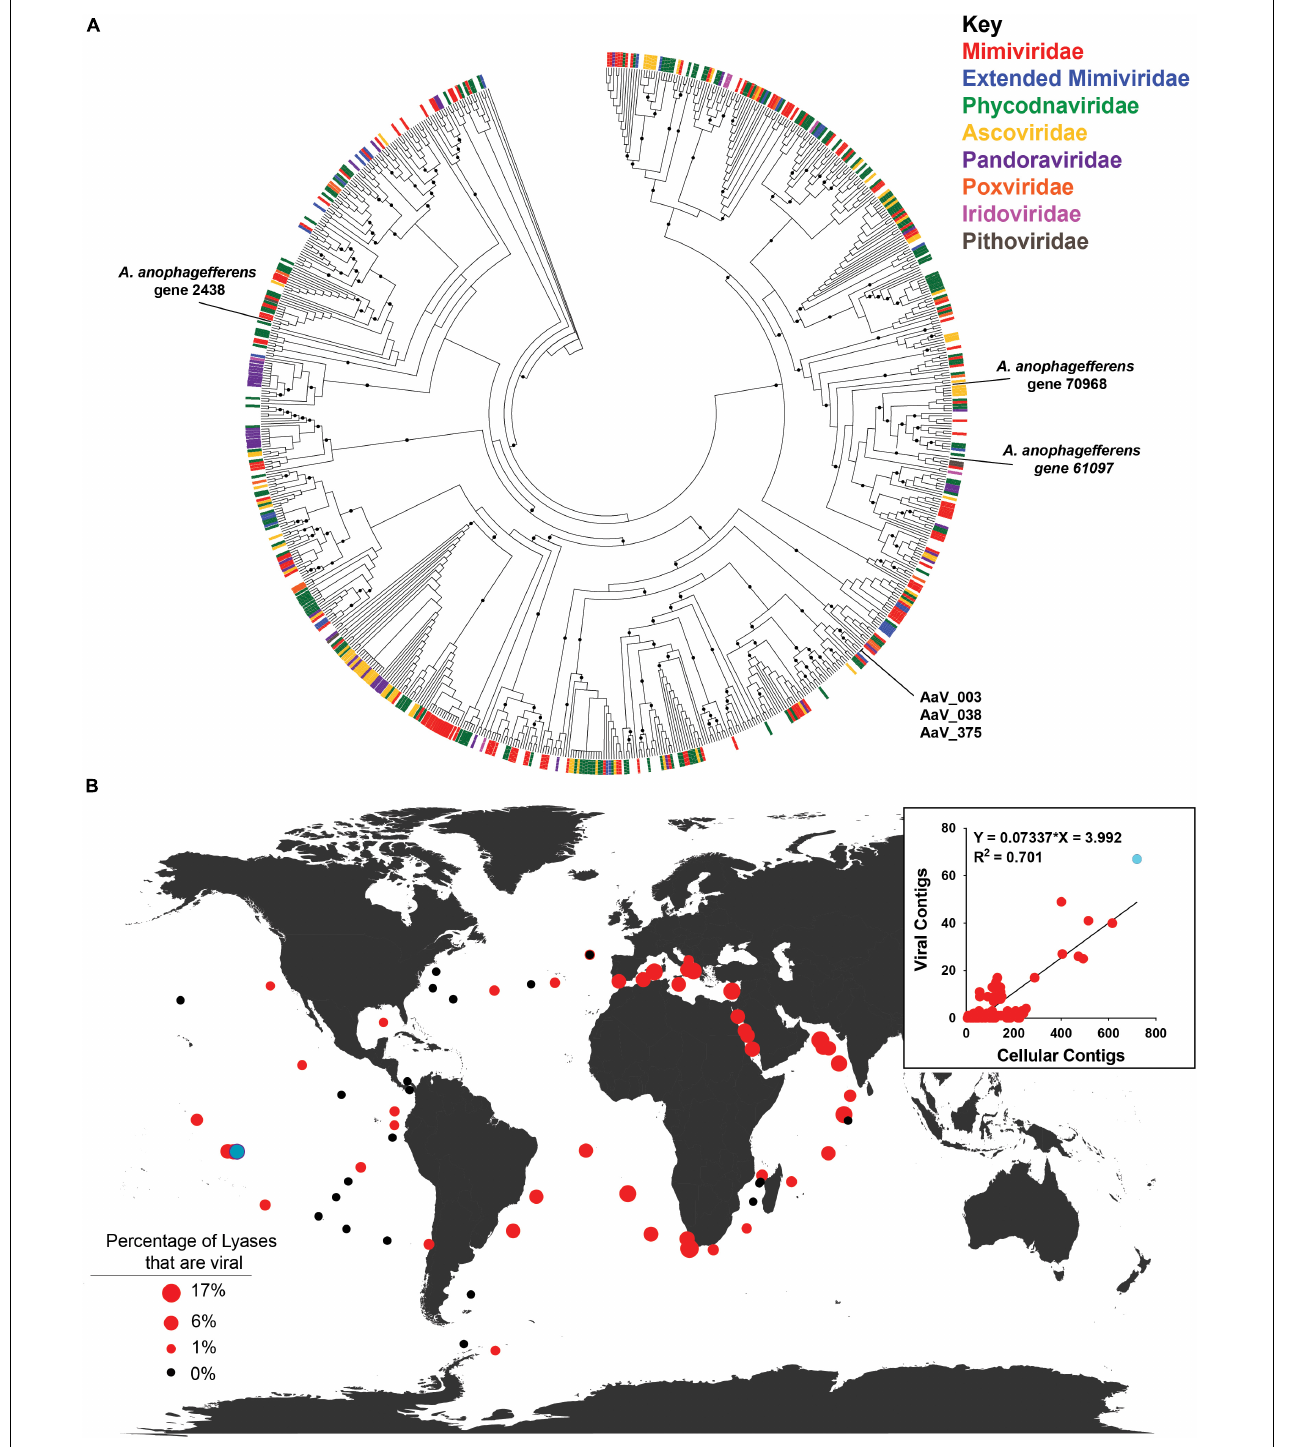
FIGURE 4 | Distribution of viral contigs containing polysaccharide lyases. (A) Maximum-likelihood phylogenetic placement of polysaccharide lyases from putative viral TARA Oceans metagenomic contigs. The classification of the contig by family based on the NCVOG on the contig are denoted by color bar. Reference-characterized polysaccharide lyases from the Carbohydrate-Active Enzyme (CAZy) Database do not have a bar at the end of their branch. Node support (aLRT-SH statistic) > 50% are shown as dark circles. (B) Contribution of polysaccharide lyases found on viral contigs to total contigs containing polysaccharide lyases for all depths at each TARA Oceans station. Black dots represent stations where no viral contigs containing polysaccharide lyases were found. Inset: TARA Oceans metagenomic contigs containing polysaccharide lyases by station. Station 122 is colored in light blue.